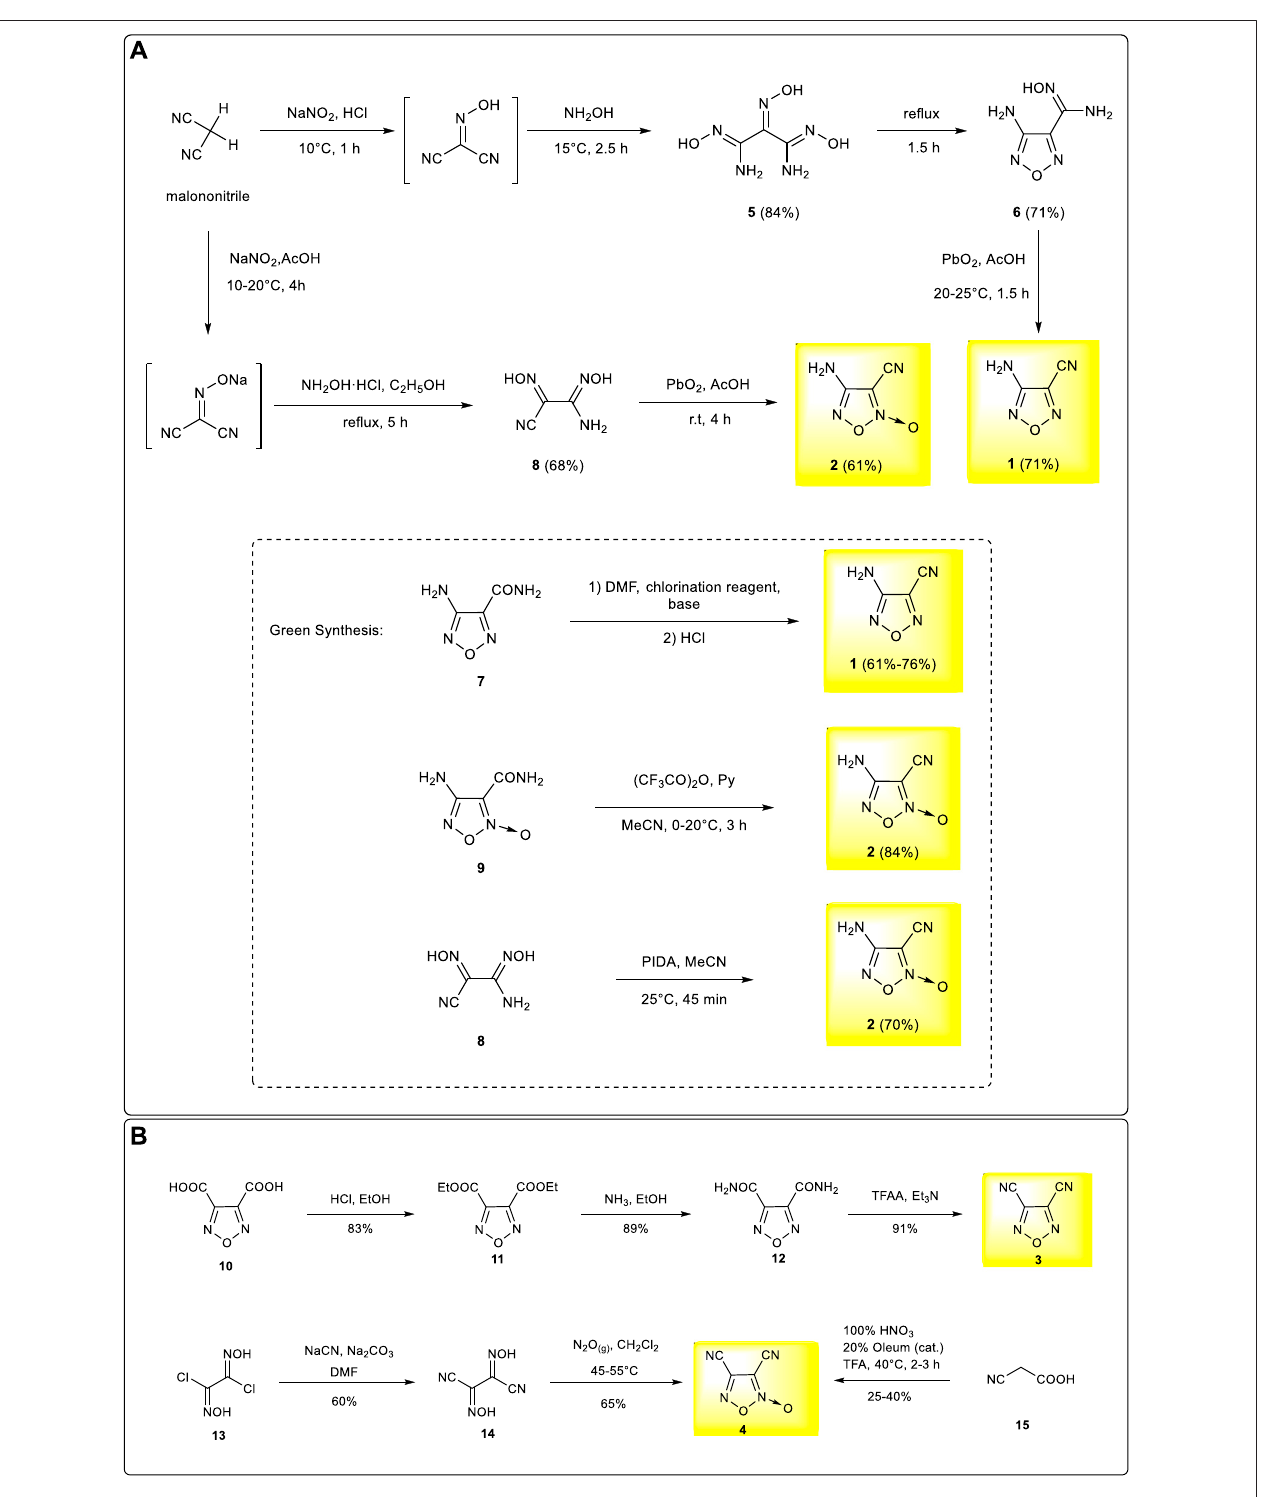
Frontiers in Chemistry |